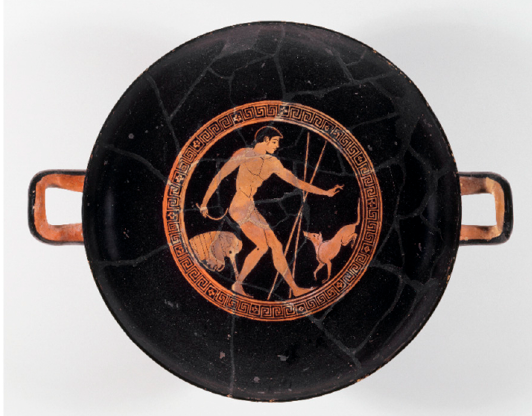
Figure 17. Allard Pierson Museum, 14.225, attr. to Tyszkiewicz Painter; Attic, red figure, 500–450. Used with permission.